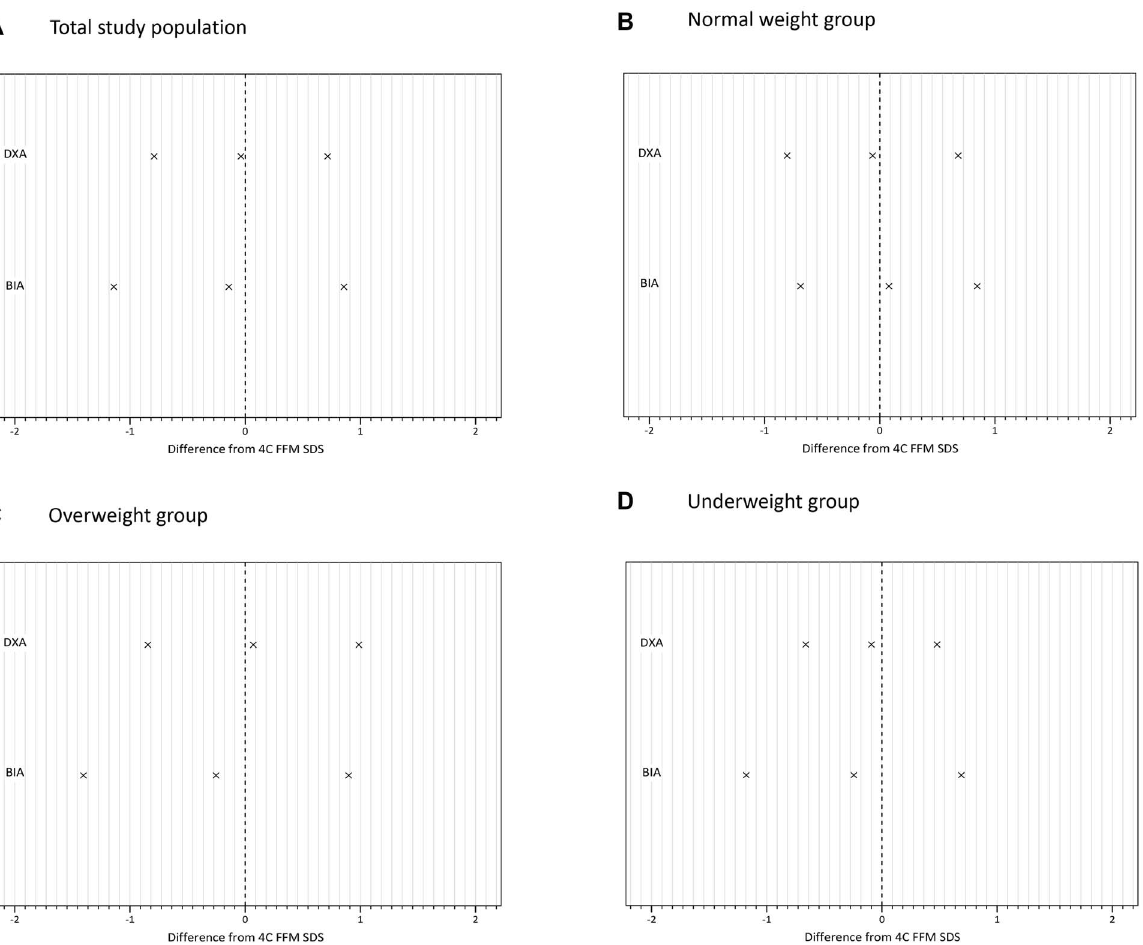
Figure 4. Mean bias and limits of agreement of each ‘simple’ method for measuring fat-free mass (FFM) when compared to the 4C (4 compartment) model: (A) total study population; (B) normal weight group; ((C) overweight group; (D) underweight group. Difference from 4C FFM SDS is calculated by subtracting the 4C FFM SDS from that of the simple method. Limits of agreement are calculated as mean bias 6 2 standard deviations (SDs). DXA; dual-energy X-ray absorptiometry, BIA; bioelectrical impedance analysis.